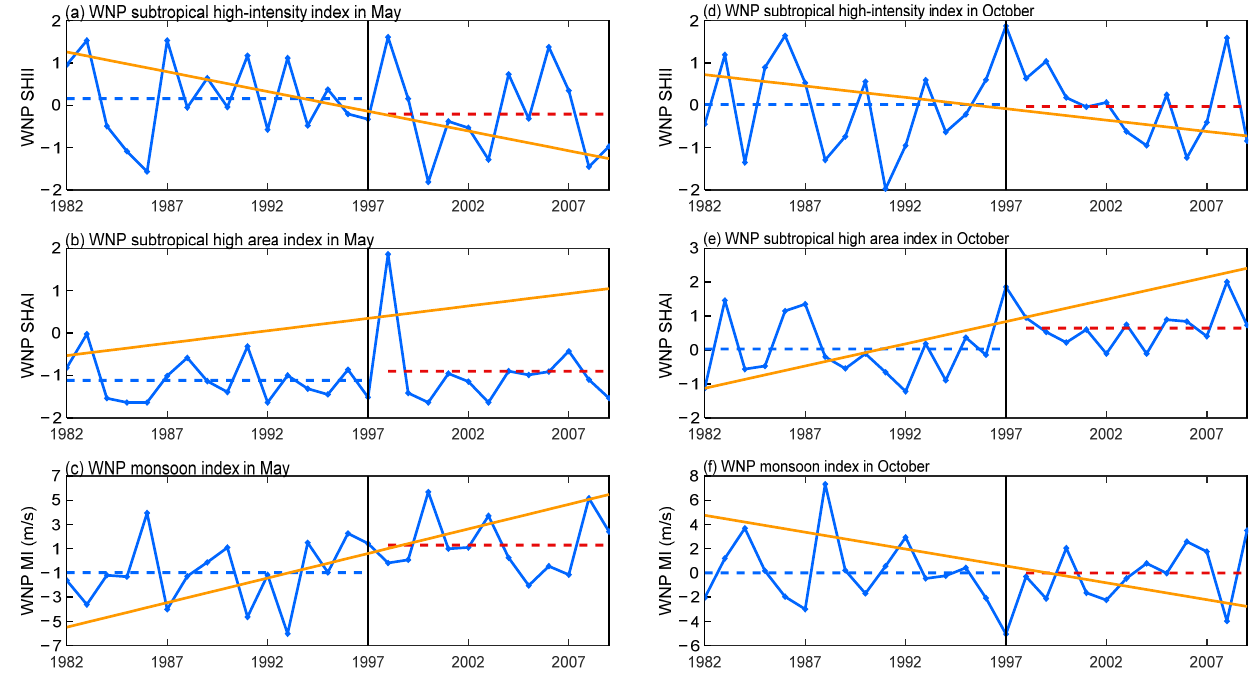
Figure 9. Time-series of WNP subtropical high-intensity index in ( a ) May and ( d ) October. WNP subtropical high area index in ( b ) May and ( e ) October, and WNP monsoon index in ( c ) May and ( f ) October. The yellow solid lines are the linear trends. The blue (red) dotted line is for the mean value during P1 and P2.